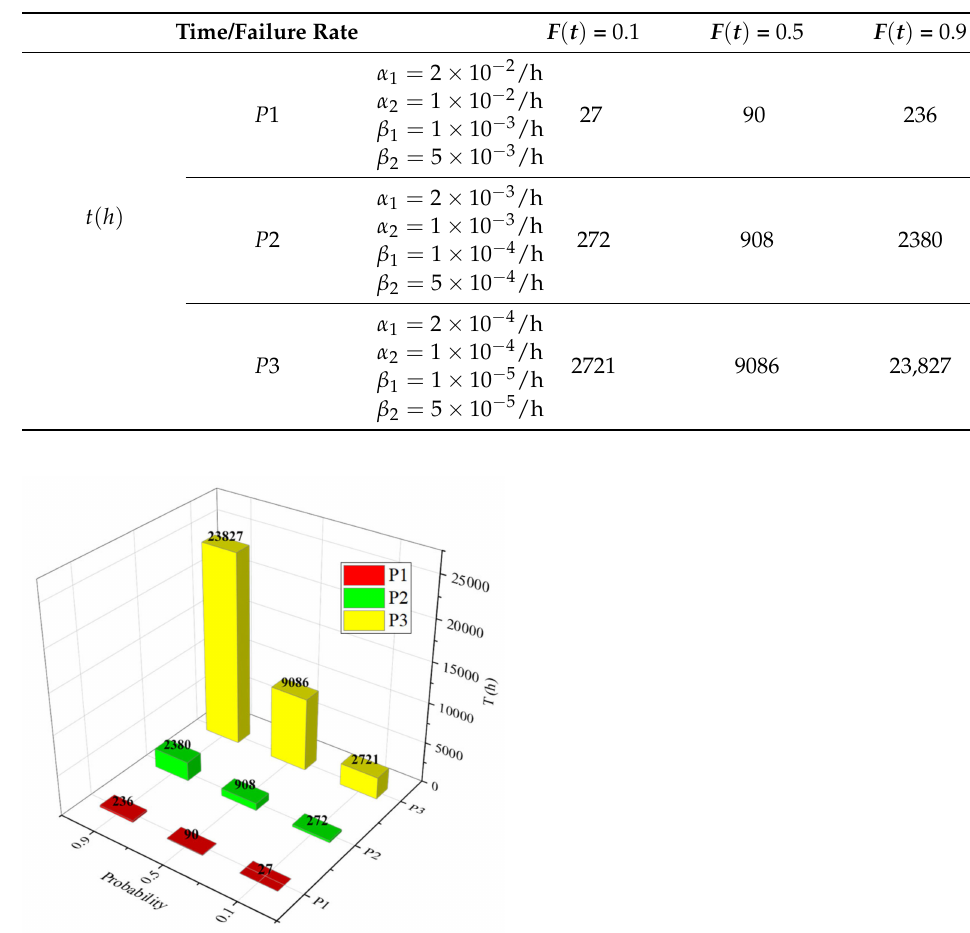
Table 3. Working hours under different fatal failure probabilities.